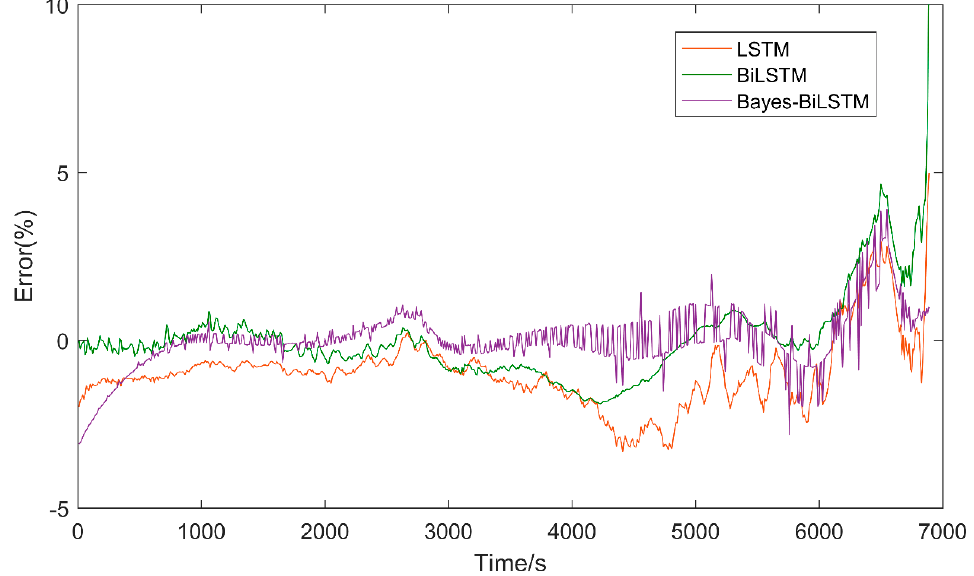
Figure 11. Comparison of the one-time battery SOC estimation results of different methods at 45 °C. Table 5. Hyperparameter optimization results.